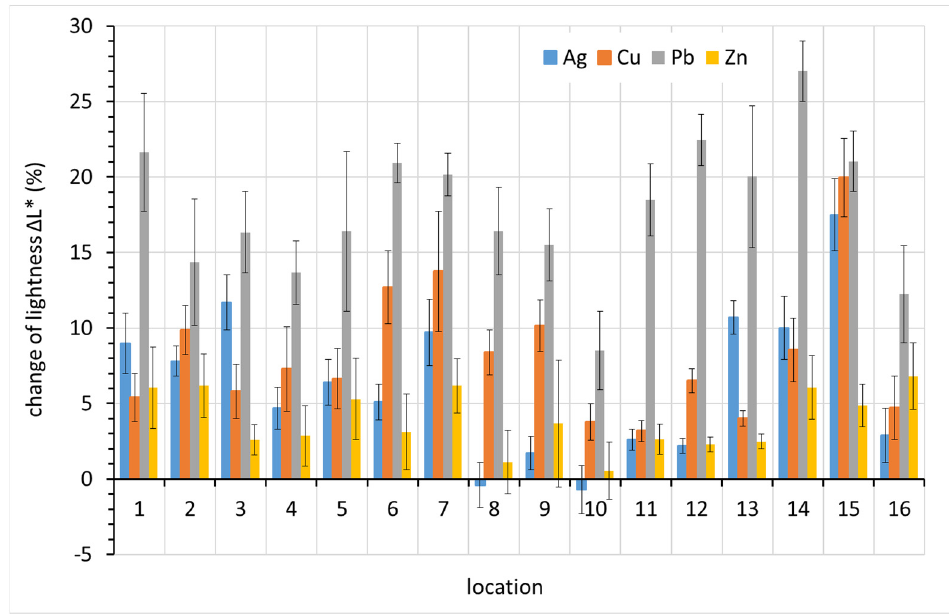
Figure 11. Change of lightness Δ L *, one of three color change components after a year of exposure of metal coupons (average values obtained from 10 recordings on different coupons before and after exposure and supplemented with standard deviation error bars). Higher value of lightness change means darker appearance.